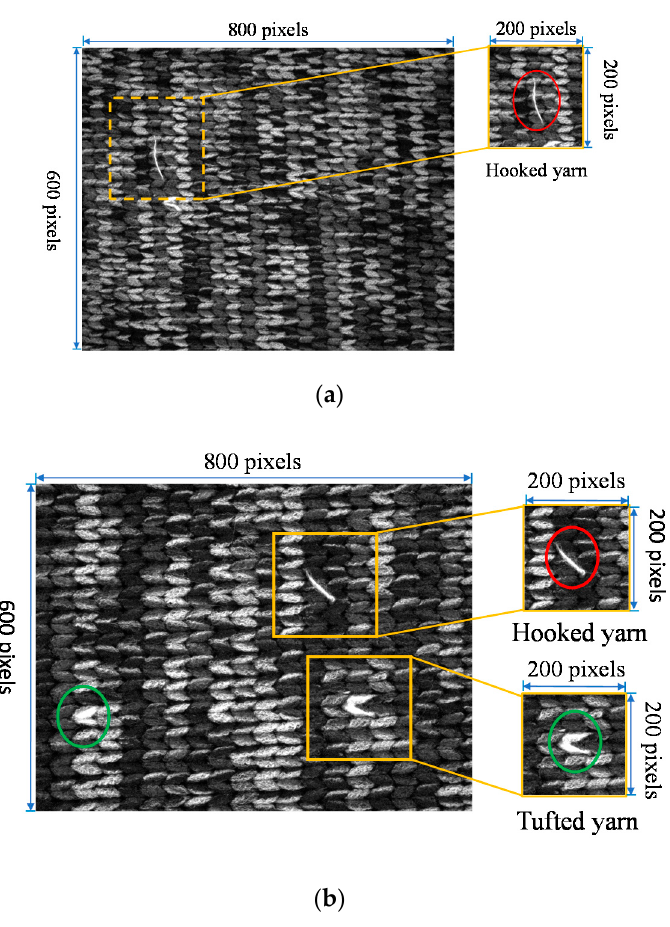
Figure 1. Self-made dataset: ( a ) Self-made datasets: ( a ) Fabric A defect map, where the area highlighted in red is the hooked yarn; ( b ) Fabric B defect map, where the area highlighted in red is the hooked yarn and the area in green is to the tufted yarn.